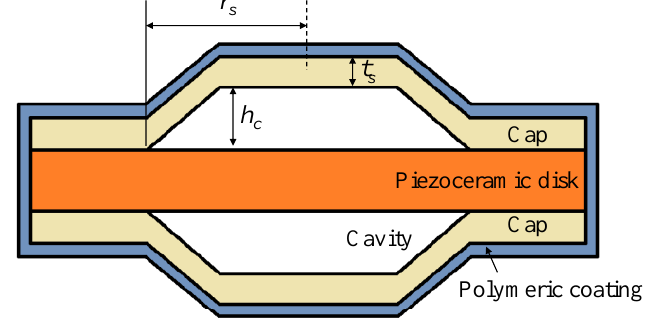
Figure 1. Schematic showing the structure of the cymbal transducer.